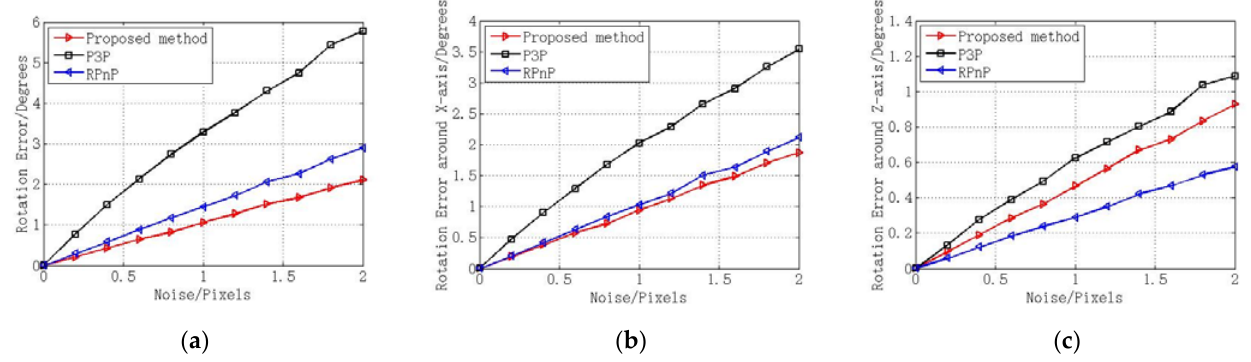
Figure 5. The performance of noise sensitivity for our proposed method (red), P3P solver (black), and RPnP solver (blue). ( a ) The total rotation error; ( b ) the rotation error around the X ‐ axis; ( c ) the rotation error around the Z ‐ axis.